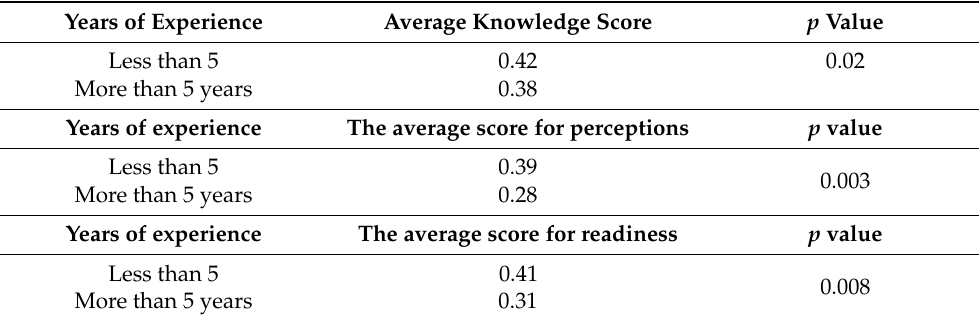
Table 6. Differences in pharmacists’ knowledge, perception, and readiness scores in relation to years of